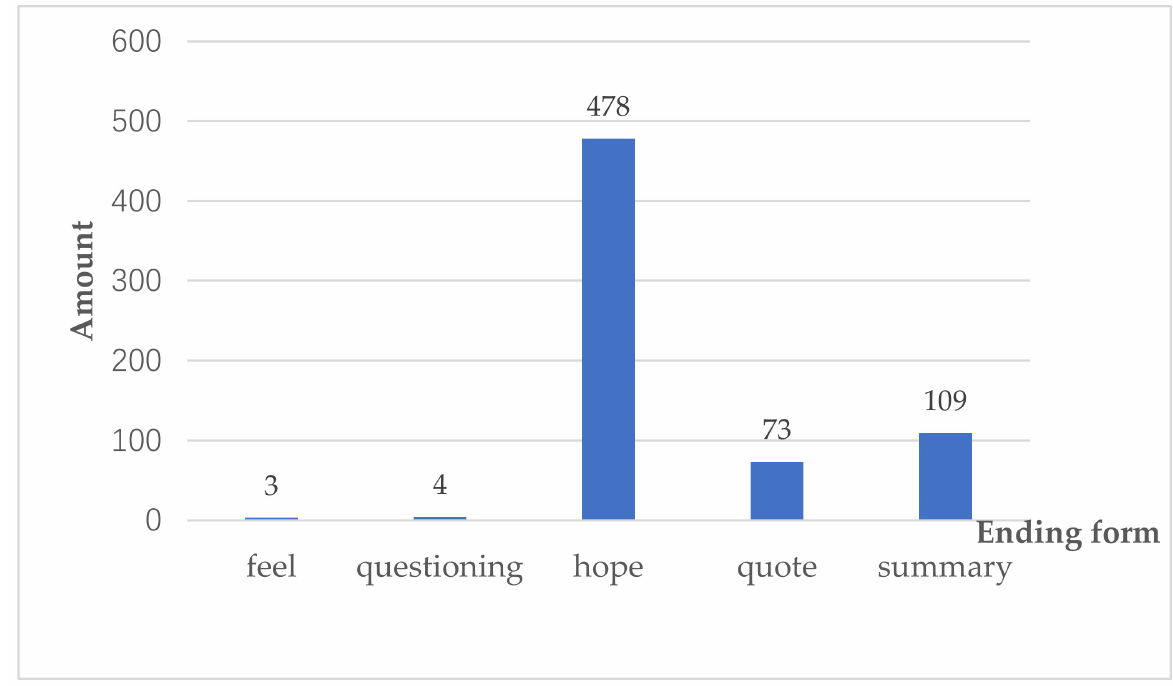
Figure 5. Clustered histogram of the main narrative angle of YiXi talk.